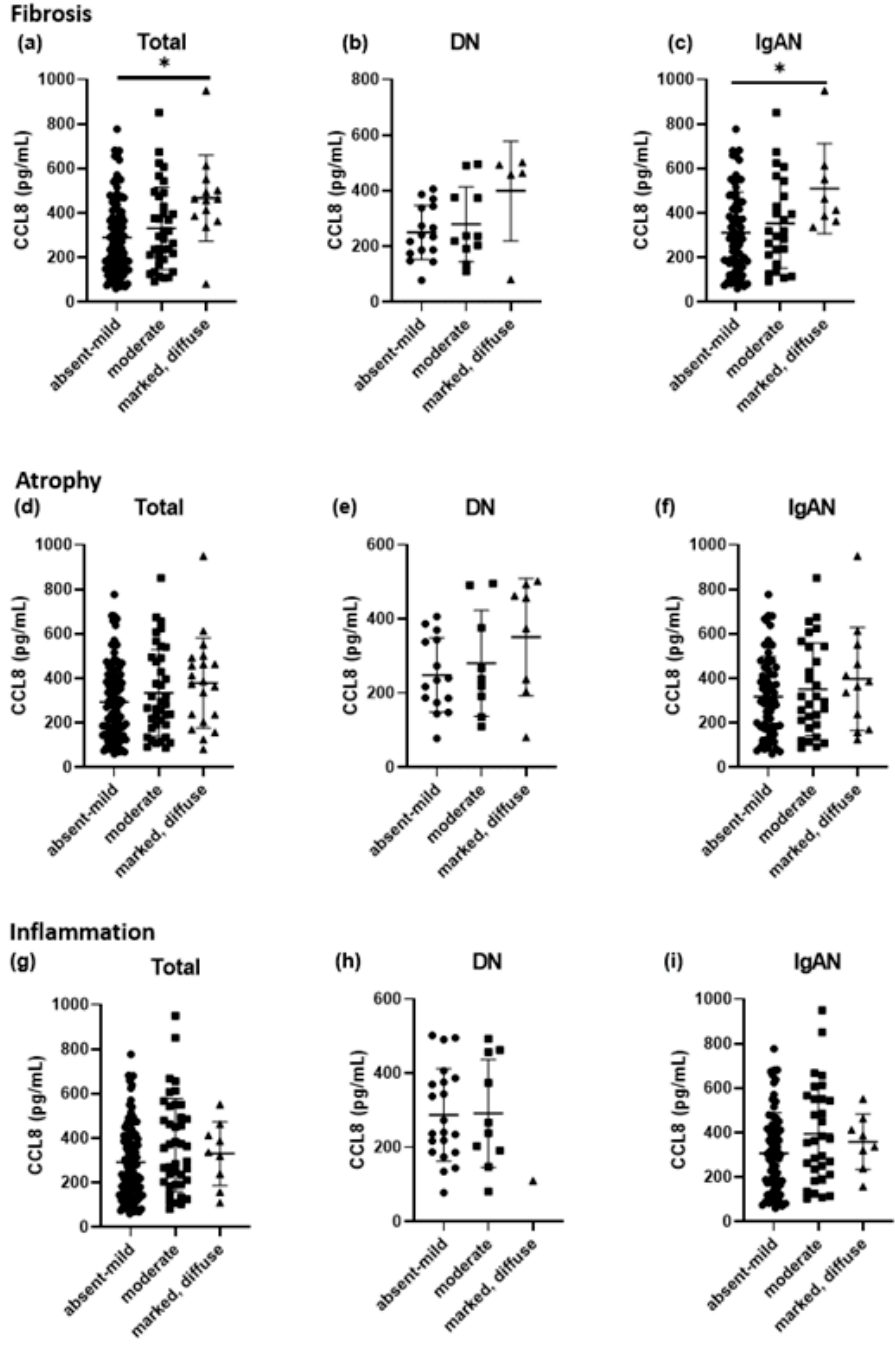
Figure 2. Serum CCL8 level were compared among patients with IgA nephropathy (IgAN, n = 110), diabetic nephropathy (DN, n = 32), and healthy controls (HC, n = 15) to investigate relation with pathologic factor of kidney biopsy result. Interstitial fibrosis ( a – c ), tubular atrophy ( d – f ), and interstitial inflammation ( g – i ) were investigated. In total patients and patients with IgAN, serum CCL8 level was significantly correlated with interstitial fibrosis ( a , c ). * p < 0.05, ** p < 0.01, and *** p < 0.001.